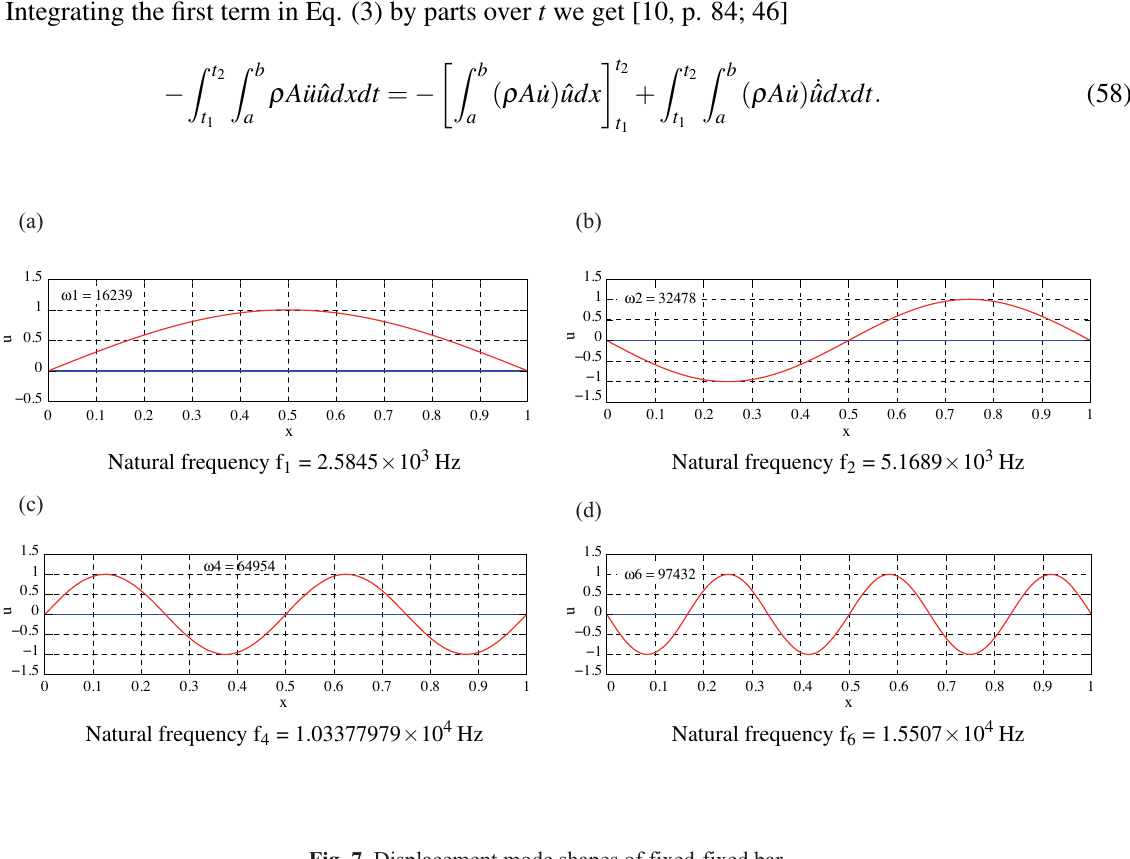
Fig. 7. Displacement mode shapes of fixed-fixed bar.